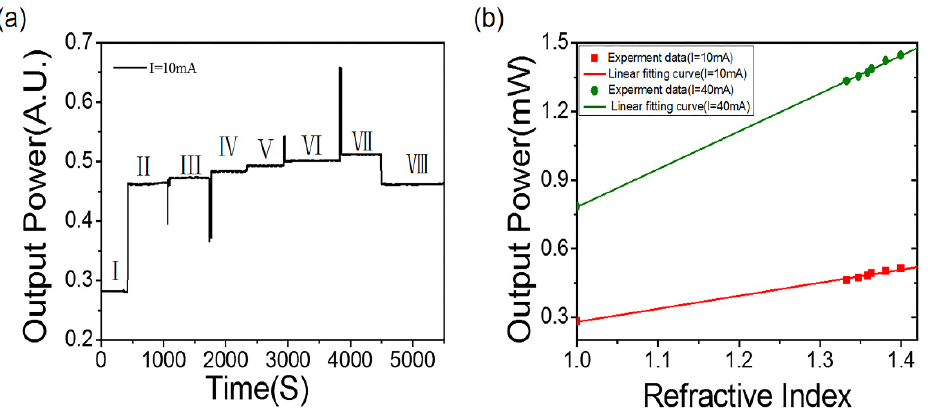
Figure 4. ( a ) Time response of LSPR sensor to different RI (I = 10 mA) sucrose solutions. ( b ) RI response of LSPR system under different input currents.